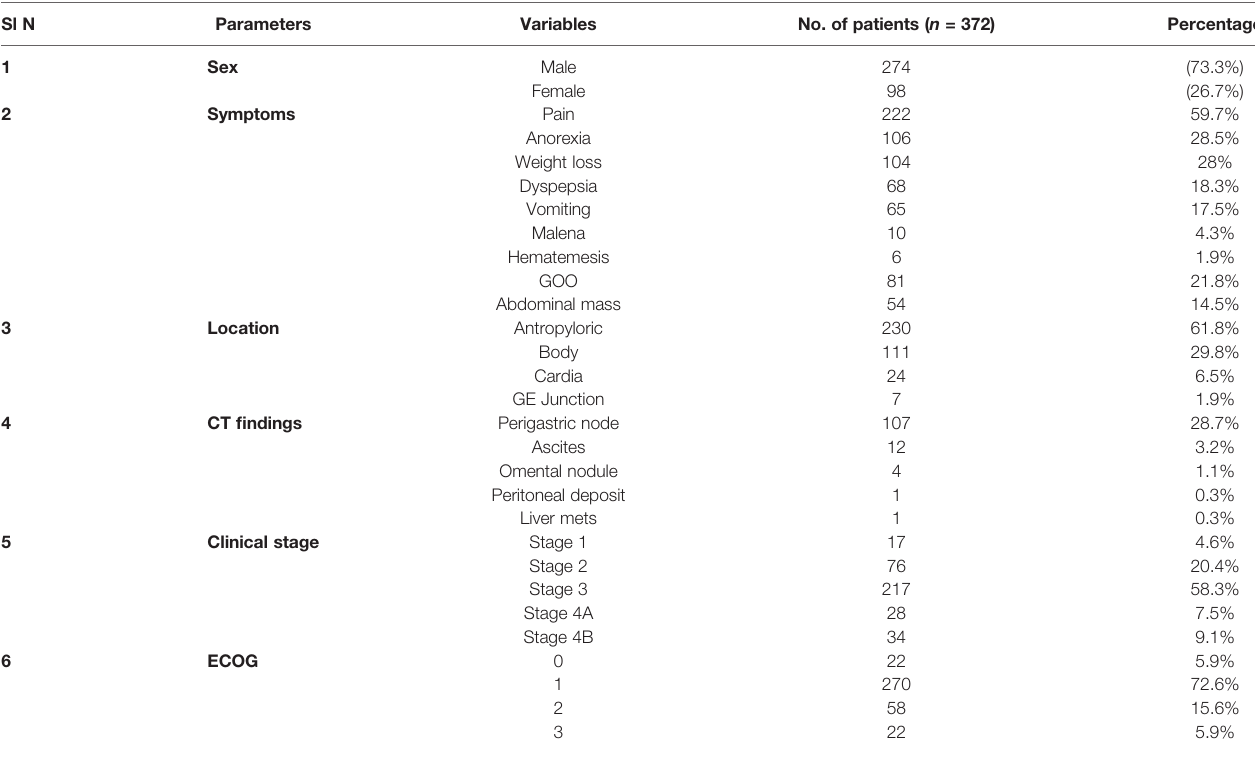
TABLE 1 | Demographic pro fi le and baseline characteristics of the